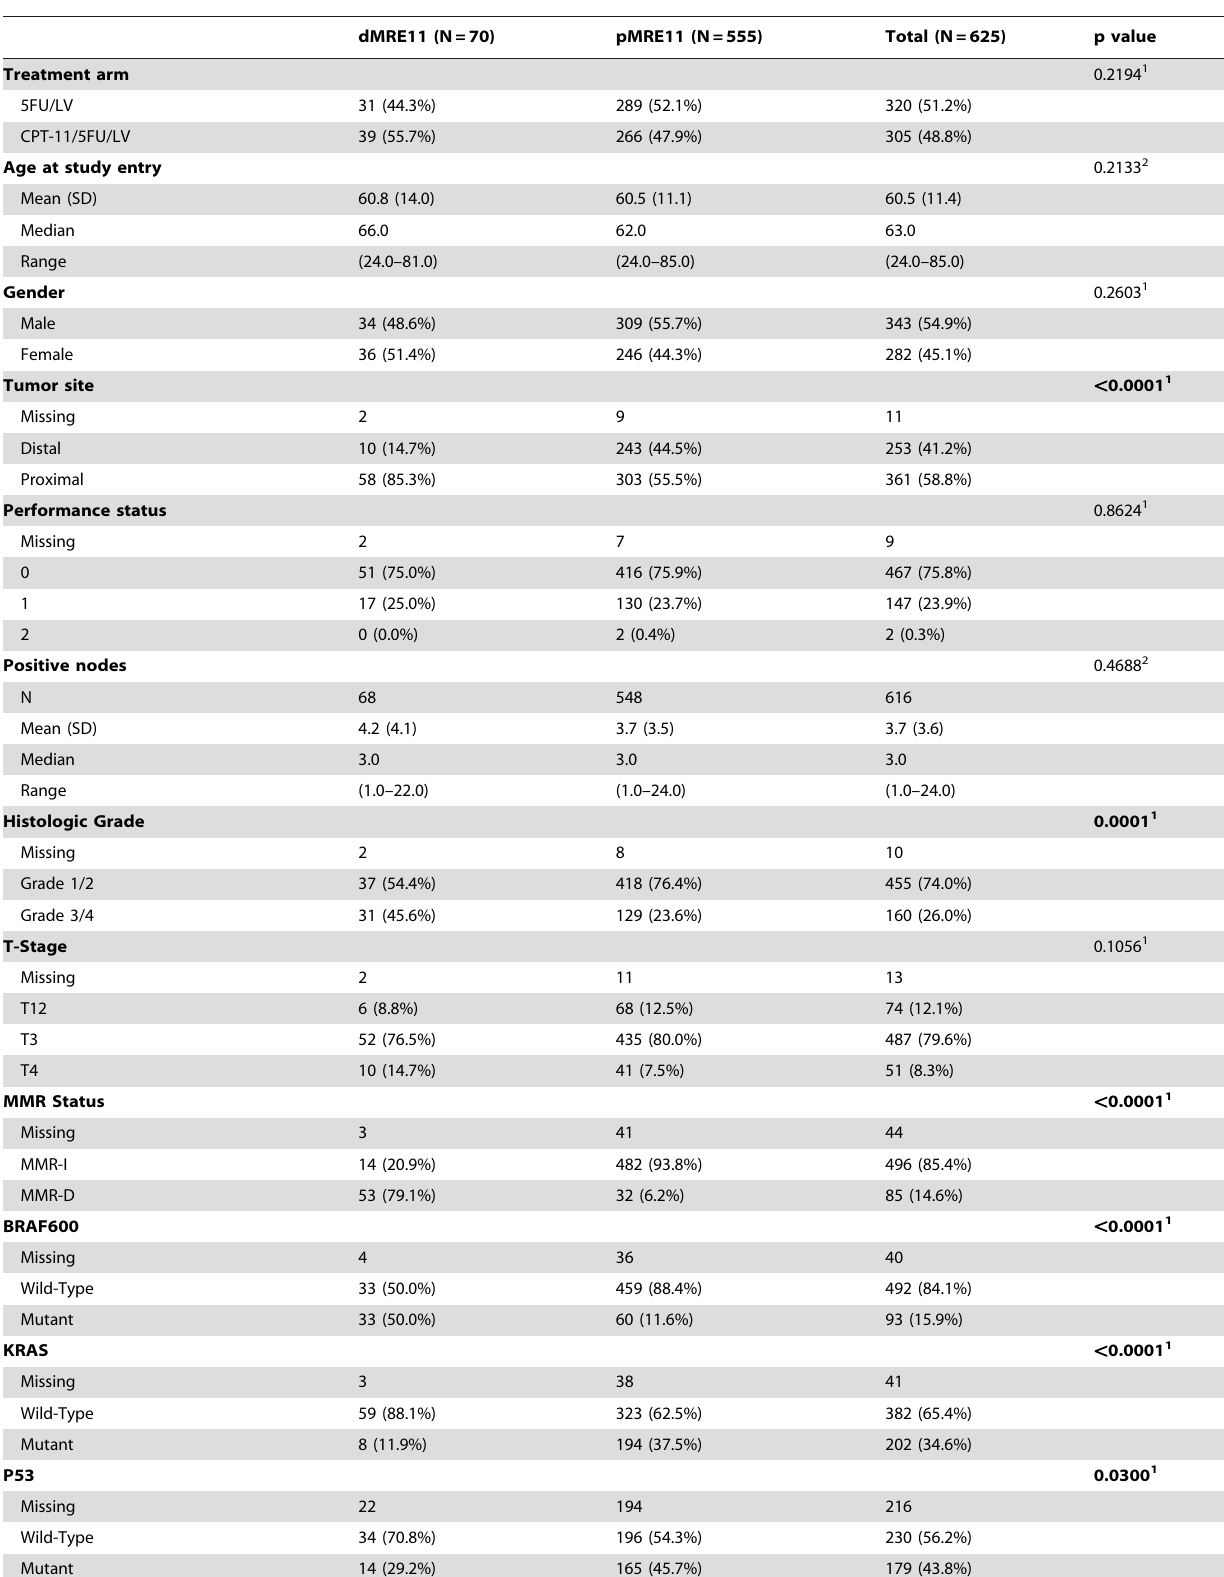
Table 2. Demographics by MRE11 Status (dMRE11 vs.